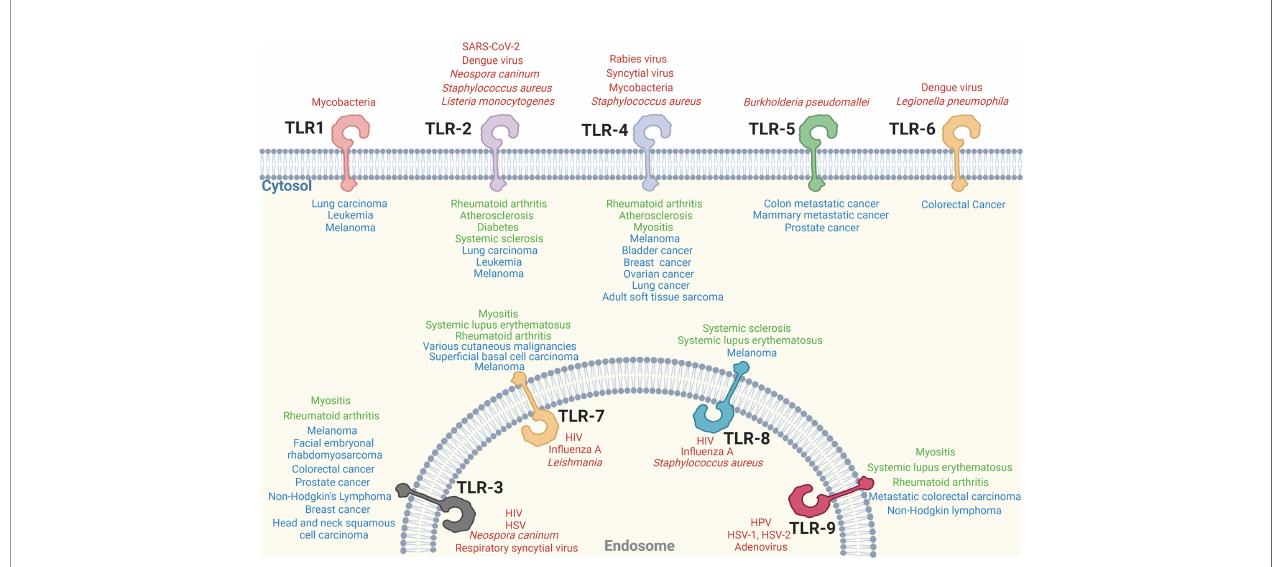
FIGURE 3 | Individual TLR singaling involves in various diseases. Individual TLR-associated infectious diseases (red), autoimmune diseases (green) and cancer (blue) are